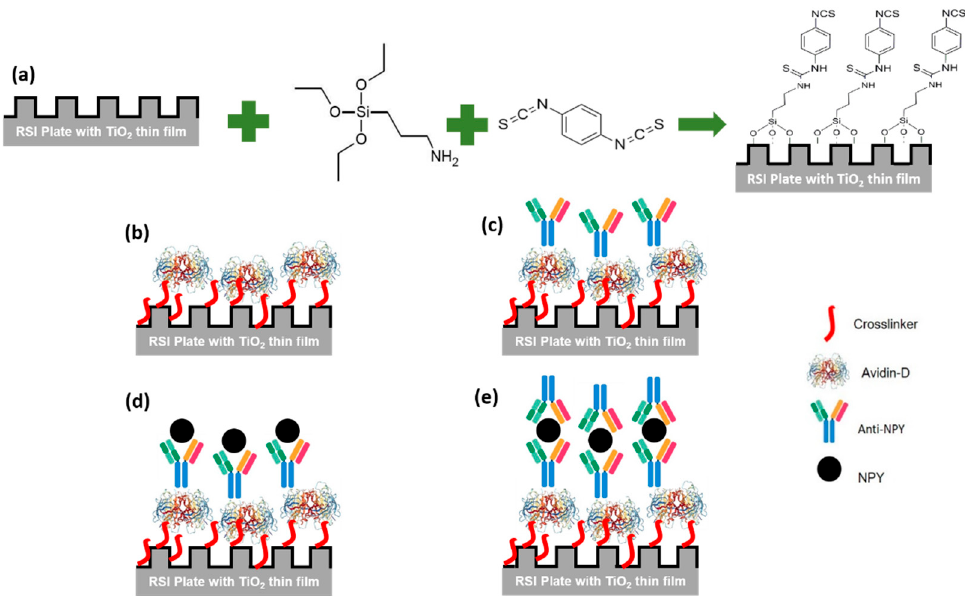
Figure 2. The sandwich neuropeptide Y (NPY) assay principle used in this work. ( a ) Plate preparation for Avidin-D attachment defining cross-linker chemistry. ( b ) Avidin-D immobilization at the sensor surface. ( c ) Covalent coupling of Avidin-D and anti-NPY [Biotin] to form the biorecognition element (BRE). ( d ) NPY attachment to the immobilized BRE. ( e ) NPY sandwich-type detection using secondary anti-NPY molecules.